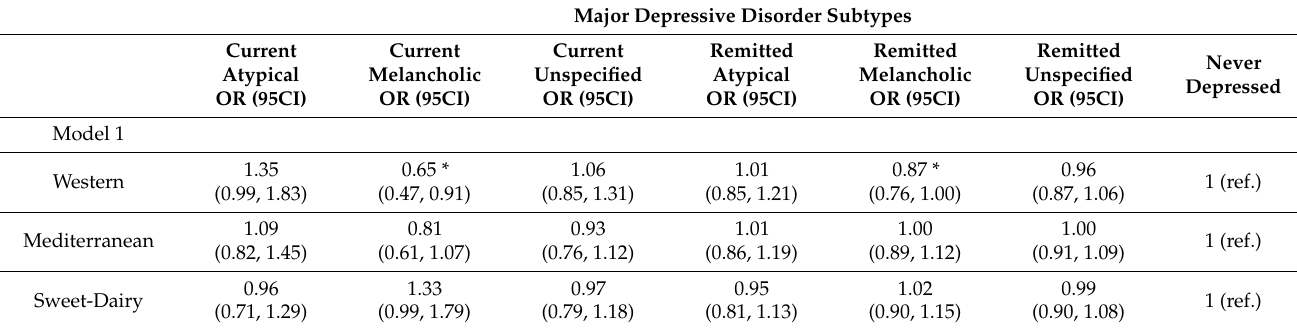
Table 3. Associations between dietary patterns and subtypes of major depressive disorder ( n =